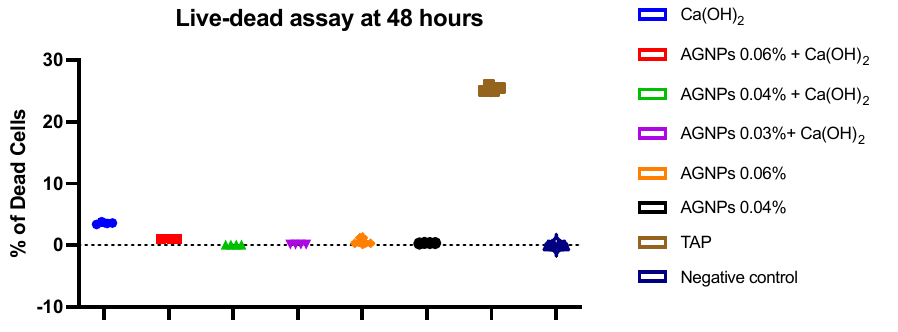
Figure 7. Percentage of dead to live cells on day 2. Data are representative of three replicas for each experimental condition, where more than 4 images were captured per condition.